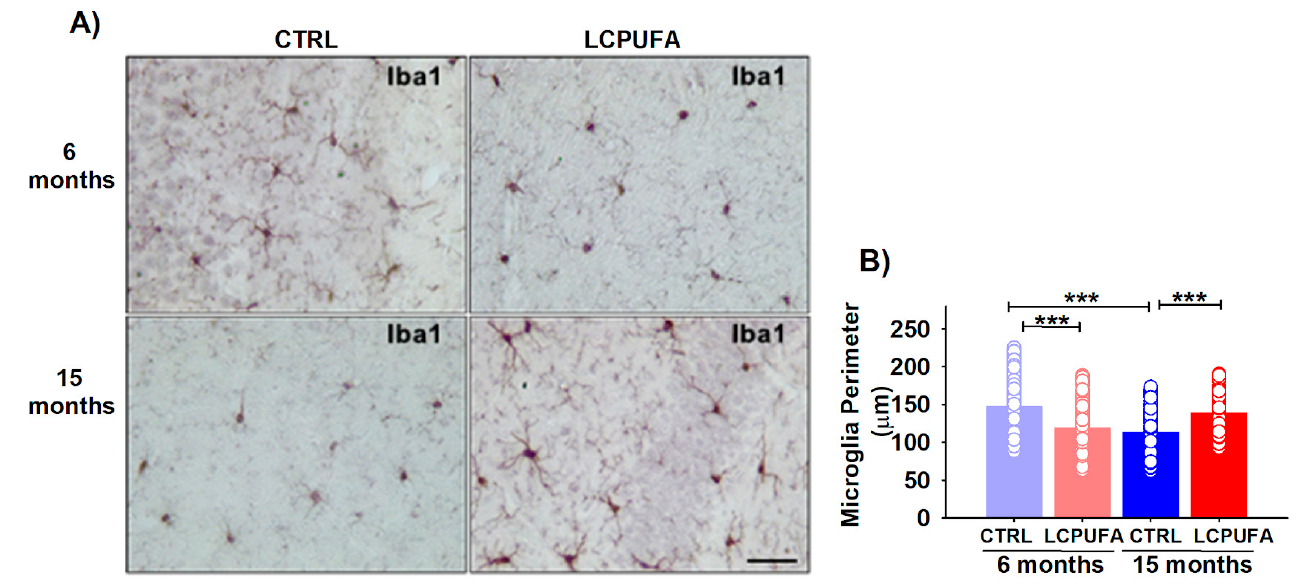
Figure 3. Microglia changes from young and aged female mice. ( A ) Representative images of Iba-1 immunostaining. A n-3 LCPUFA-enriched diet normalizes microglia activation induced by aging in the hippocampus of female mice. Immunohistochemistry was performed in fixed horizontal brain slices from 6- and 15-months-old female mice fed CONTROL or n-3 LCPUFA-enriched diets as indicated in the Methods. Scale bar = 40 µ m. ( B ) Microglia perimeter is reduced in the hippocampus of 15-months-old female mice. The n-3 LCPUFA-enriched diet decreases the microglia perimeter in 6-months-old female mice but normalizes it in 15-months-old female mice. Bars represent the mean perimeter length (micrometers) ± SEM from 188–314 microglial cells per group, measured as described in the Methods. Circles represent each individual measurement. Data were analyzed by a 2-way ANOVA (diet, age) and Sidak’s post hoc test (*** p < 0.001). n = 4 animals per group.